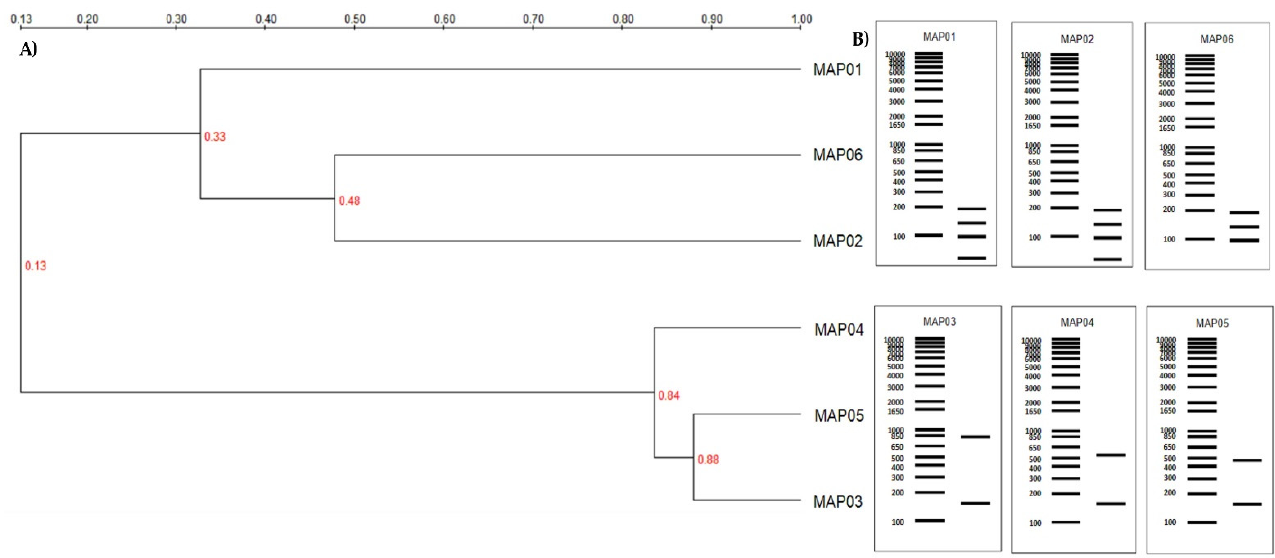
Figure 1. RAPD analysis dendrogram and PCR-RFLP patterns. ( A ) RAPD analysis using Primer 5, ( B ) A PCR-RFLP pattern for the ITS region was performed with two restriction endonucleases on two different strain groups: Group A: Emmia latemarginata strains (MAP03, MAP04, and MAP05) used the enzymes Sal I and Alu I ; and Group B: Mucor circinelloides strains (MAP01, MAP02 and MAP06) used the enzymes HindIII and MboI .